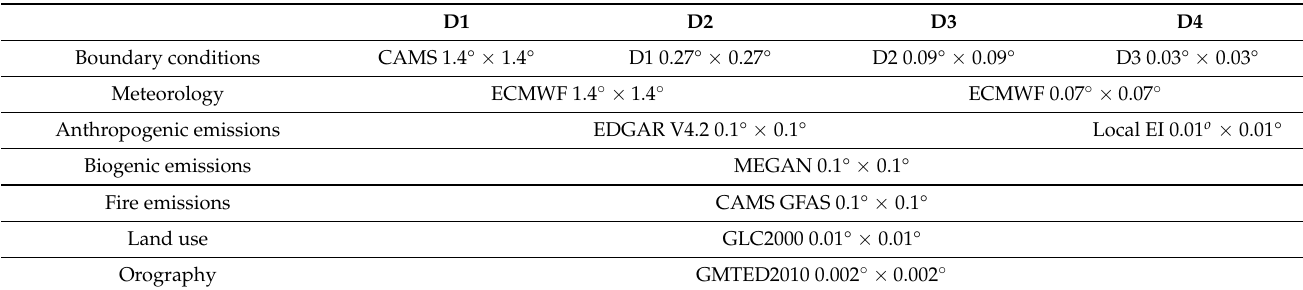
Table 2. LOTOS-EUROS simulations setup. LOTOS-EUROS outputs were written hourly. Meteorological data had a temporal resolution of 3 h.